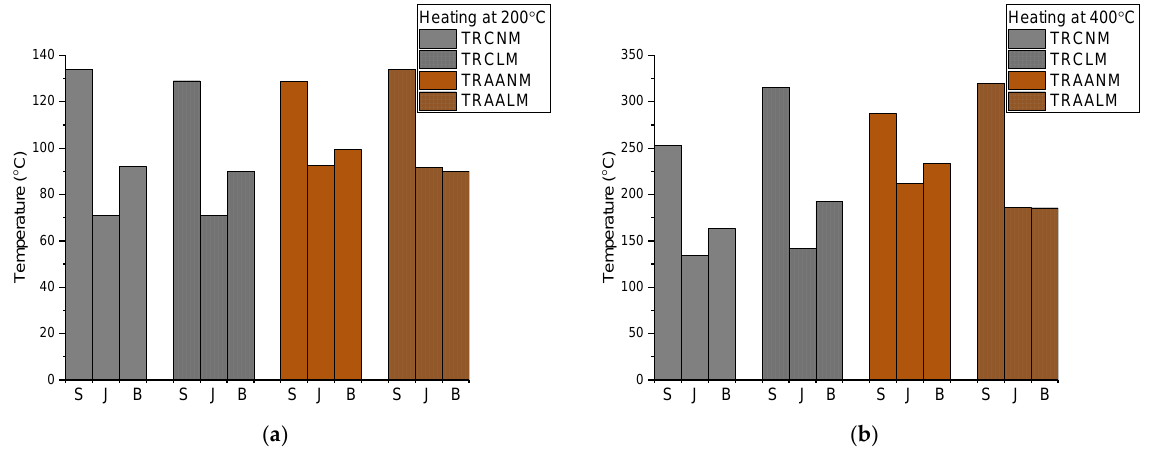
Figure 12. Temperatures at the TRMs’ surface (S), the TRM/masonry joint interface (J), and the TRM/brick interface (B) in specimens that were heated at: ( a ) 200 °C and ( b ) 400 °C. (In case more than one temperature value exists for identical specimens, the average values are considered).